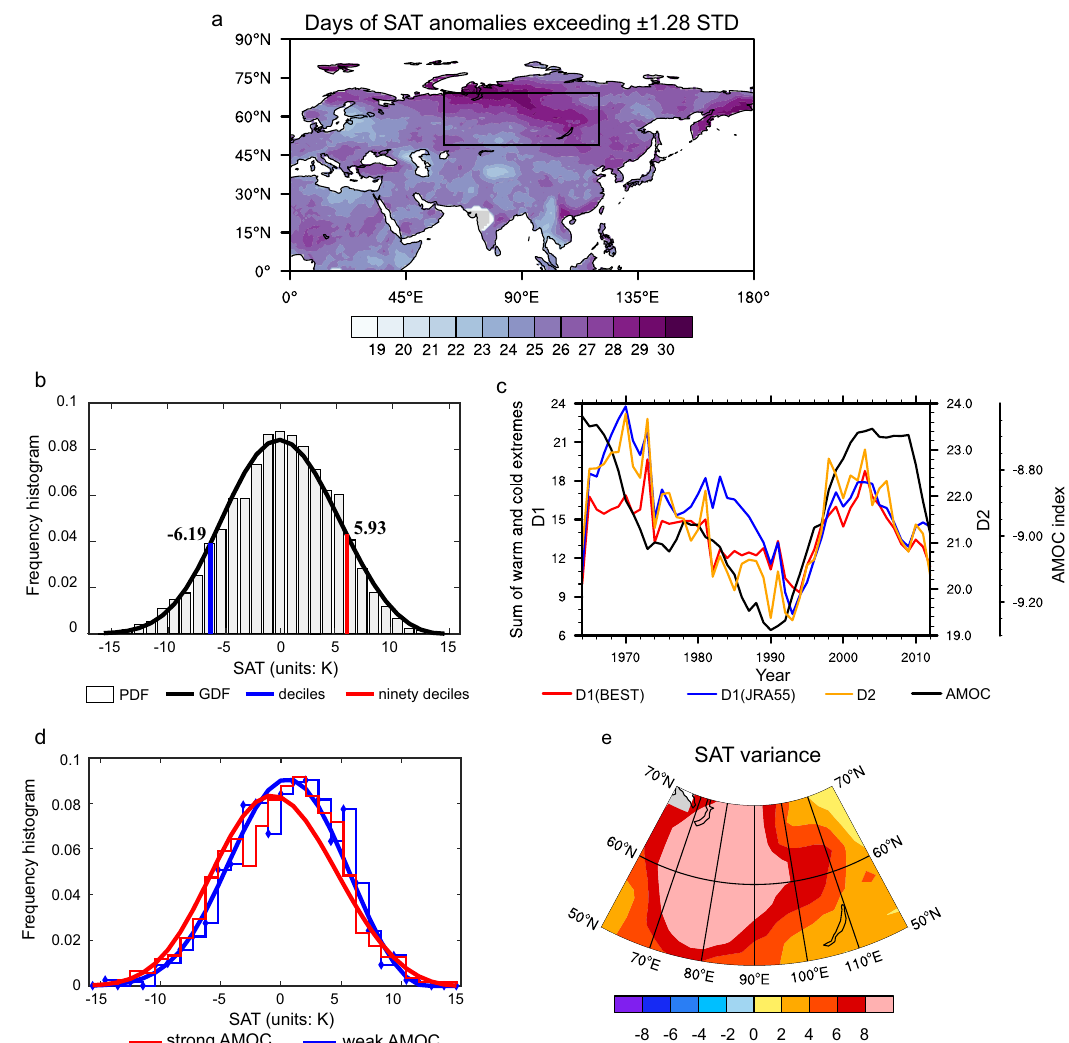
Fig. 1 Spatial and temporal characteristics of the winter SAT extremes over Siberia and their relationship with AMOC. a Spatial distribution of the Sums for the days (units: days season − 1 ) with the SAT anomaly either greater than its 1.28 STD or less than − 1.28 STD in winter during 1960 – 2016; the black box is the Siberian region. b Frequency histogram (bars) and GDF fi tting (curve) of the winter SAT anomalies (units: K) over Siberia during 1960 – 2016. c Decadal changes in the frequencies (days season -1 ) for the Sums over Siberia in winter based on D1 using the BEST and JRA55 datasets and D2 and the fi ngerprint AMOC index during 1960 – 2016 (the year 1964 represents the 9 years ’ moving average from 1960 to 1968). d Frequency histograms (staircase curves) and GEV fi ttings (smooth curves) of the winter SAT anomalies (units: K) over Siberia during the weak AMOC (blue lines) and strong AMOC phases (red lines). e Differences in the variances (unit: K 2 ) of the winter SATs over Siberia between the strong and weak AMOC phases. The SAT anomalies in a , b , d , and e are from the BEST